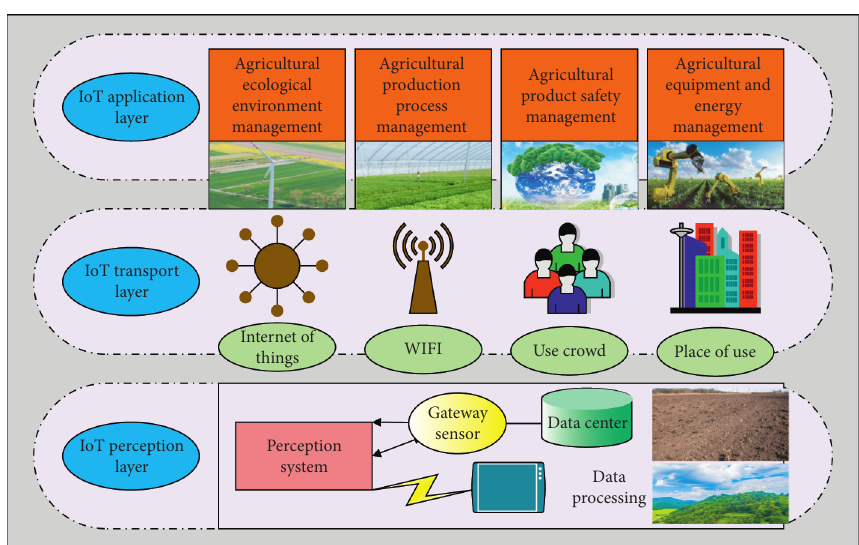
Figure 1: Agricultural IoT